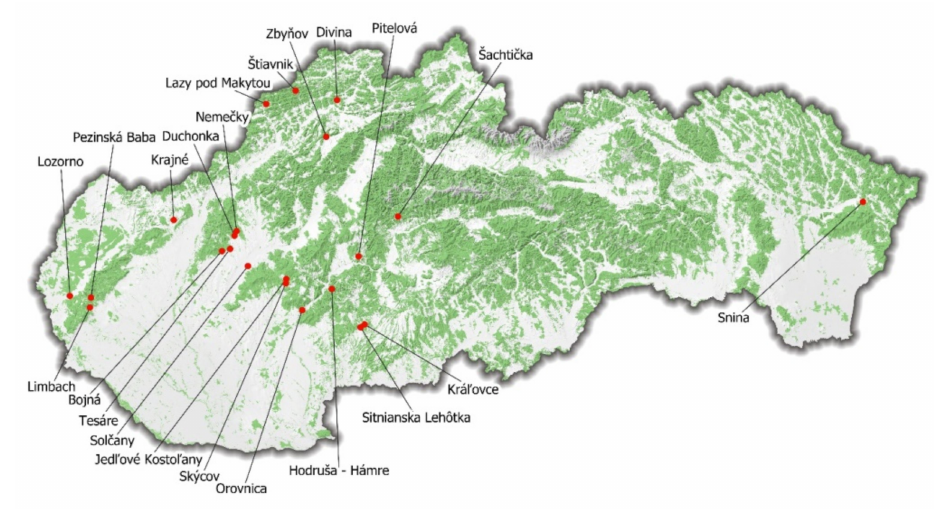
Figure 1. Mushroom and its underlying soil sampling localities in